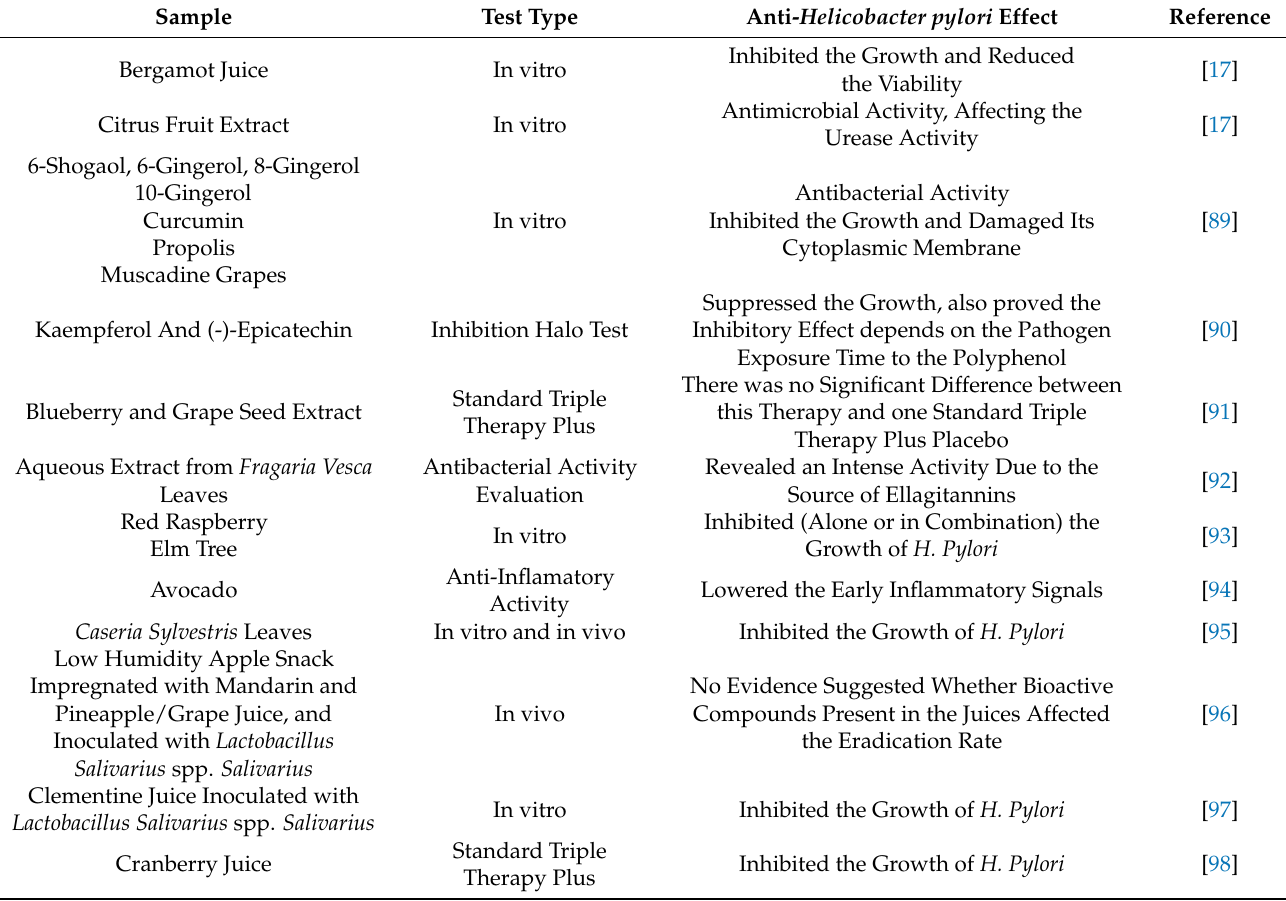
Table 2. Juices, plant extracts, and polyphenols with anti- H. pylori